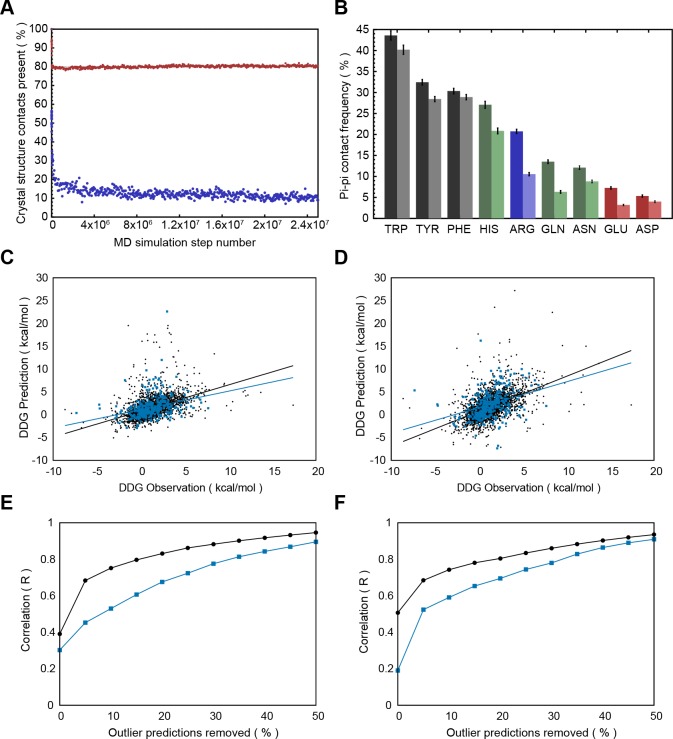
Pi-pi interactions underestimated by some energy functions.(A), Contact frequency during molecular dynamics simulations of 100 proteins, made available through Dynameomics (Kehl et al., 2008), shows a rapid initial loss of >80% of sidechain pi-contacts which continues to decline throughout the simulation (blue points). By comparison, sidechain hydrogen bonding shows a stable loss of only 20% of interactions (red points). (B), Minimization of 762 crystal structures against the Talaris2014 energy function by Rosetta3.4 (Leaver-Fay et al., 2011; O'Meara et al., 2015), with starting contact frequencies (left bars) decreasing after minimization (right bars). (C–F), Analysis of the relationship between the energetic effects of point mutations (ΔΔG) and pi-contacts for experimental ΔΔGs (blue bars) and ΔΔGs predicted by simulation against the FOLDX force field (Schymkowitz et al., 2005) (C,E) and Rosetta (D,F). Panels C,D show predicted ΔΔG values vs. observation for residues that are not involved in pi-contacts in black, and residues that are involved in pi-contacts in blue, with lines of best fit colored the same. Panels E,F show how correlation values change as outliers are removed, with correlation consistently worse for mutations involving pi-contacts (blue lines) relative to those that don’t (black lines).